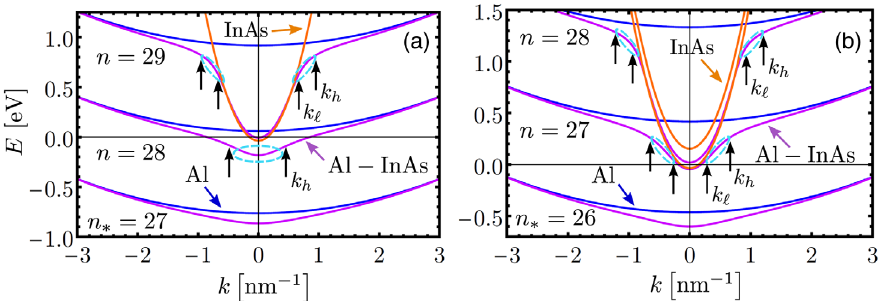
FIG. 7. Panels (a) and (b) depict the two possible hybrid band structure scenarios for energies in the vicinity of the isolated InAs conduction band edge. The band structures shown are obtained via the self-consistent Schrödinger-Poisson method for Φ ¼ 0 . 1 eV and L 2 ¼ 100 nm. In (a) [(b)] we have L 1 ¼ 5 nm [ L 1 ¼ 4 . 75 nm] and we have additionally shown the relevant pure Al and InAs bands for L 0 2 ¼ 16 nm. The dashed (cyan) ellipses illustrate band segments of strong superconductor-semiconductor hybridization which glue the ; see Eq. (15). In (a) we encounter scenario I in which k l ¼ 0 for pure Al and InAs bands together and generally appear for k l ≤ k ≤ k h n ¼ n þ 1 and a band appears below the pure InAs bands due to the hybridization-induced downward bending of the ð n þ 1 Þ th pure (cid:3) (cid:3) Al band. This scenario is realized when the condition of Eq. (16) is satisfied. In contrast, in (b) this condition is not satisfied and a separated band does not appear below the pure InAs levels. However, gluing segments with k l > 0 appear, to connect the pure InAs and Al